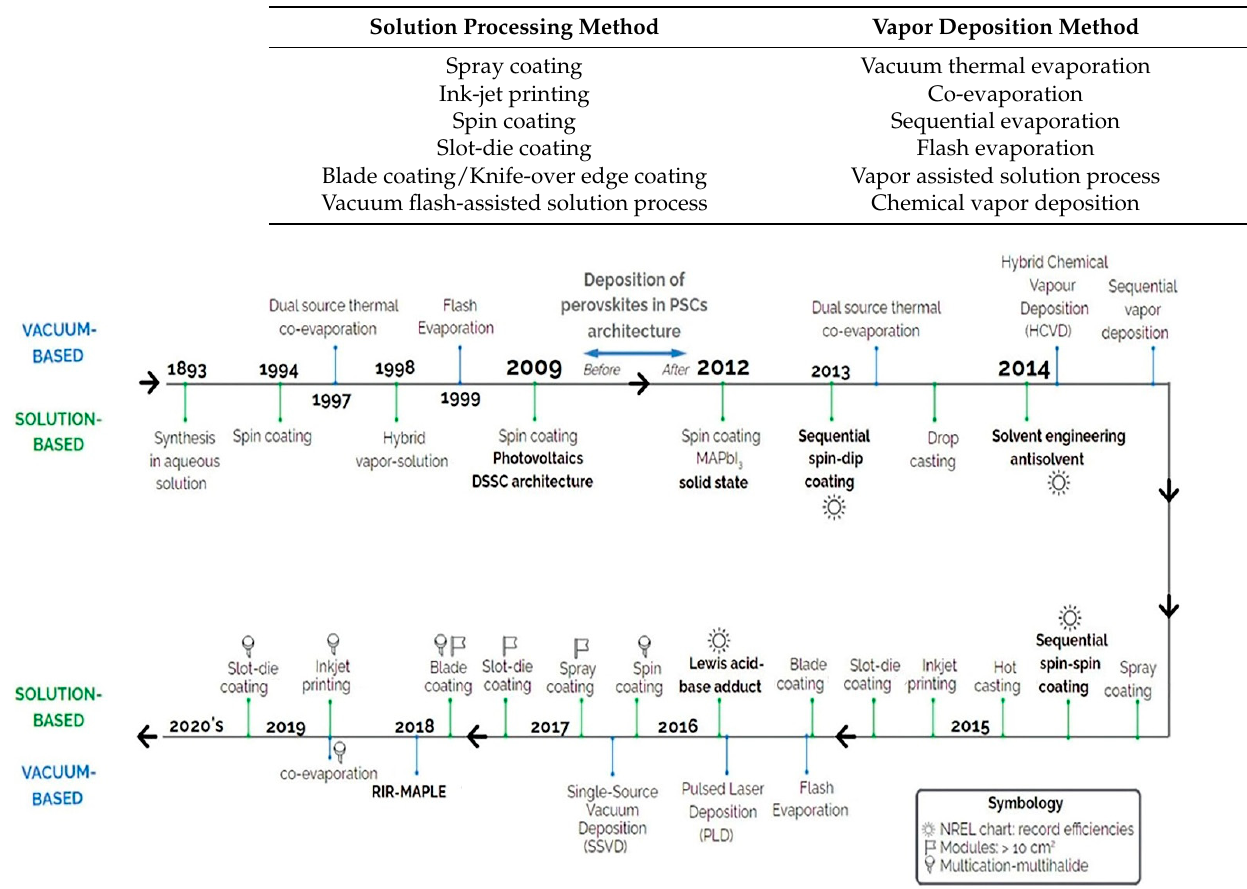
Table 1. Large-area perovskite thin-film fabrication methods used in the current work [15,17,23,40,41,43].